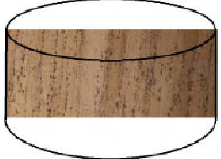
Figure 9. SEM sampling